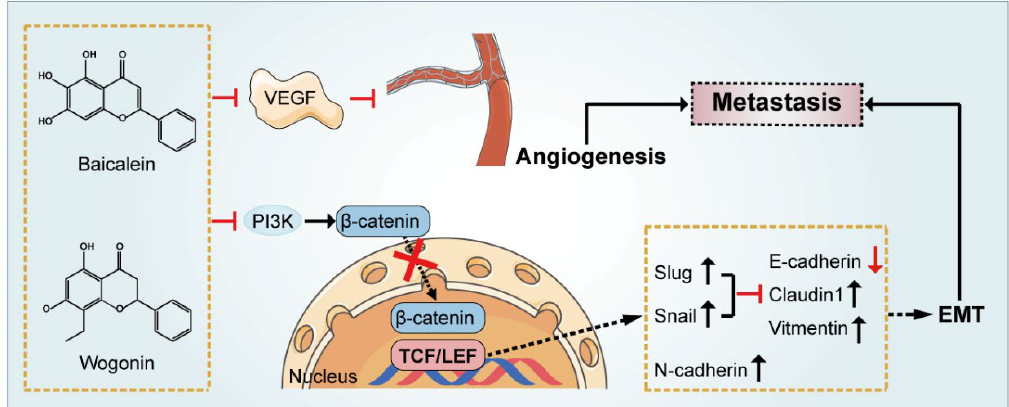
Figure 2. Cellular targets of baicalein and wogonin in modulating tumor cells angiogenic and metastasis. On one hand, baicalein and wogonin directly decreasing the level of vascular endothelial growth factor, thereby suppressing cancer cell angiogenesis. On the other hand, by inhibiting the nuclear translocation of β -catenin and T-cell family binding affinity, baicalein and wogonin eventu- ally reverse the epithelial-mesenchymal transition effect. The black arrows represent up-regulated expression of proteins, and the red arrows represent down-regulated ones. Red cross indicates in- hibition.